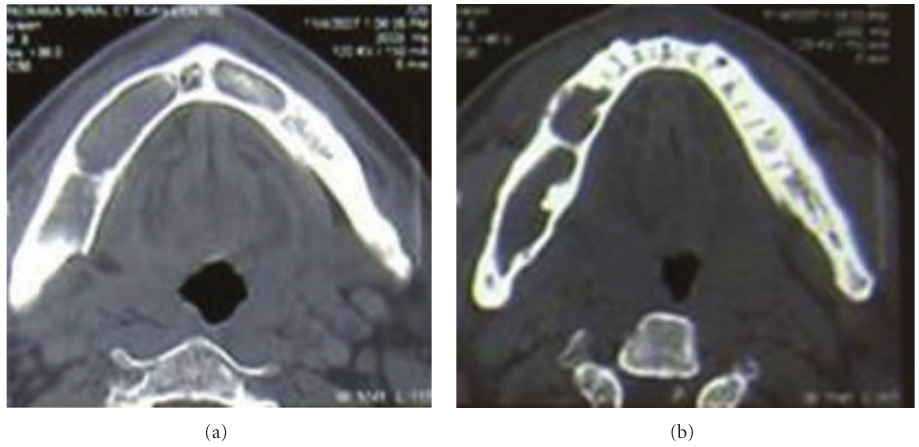
Figure 6: CT scan showing cystic lesions of body and condyle of the